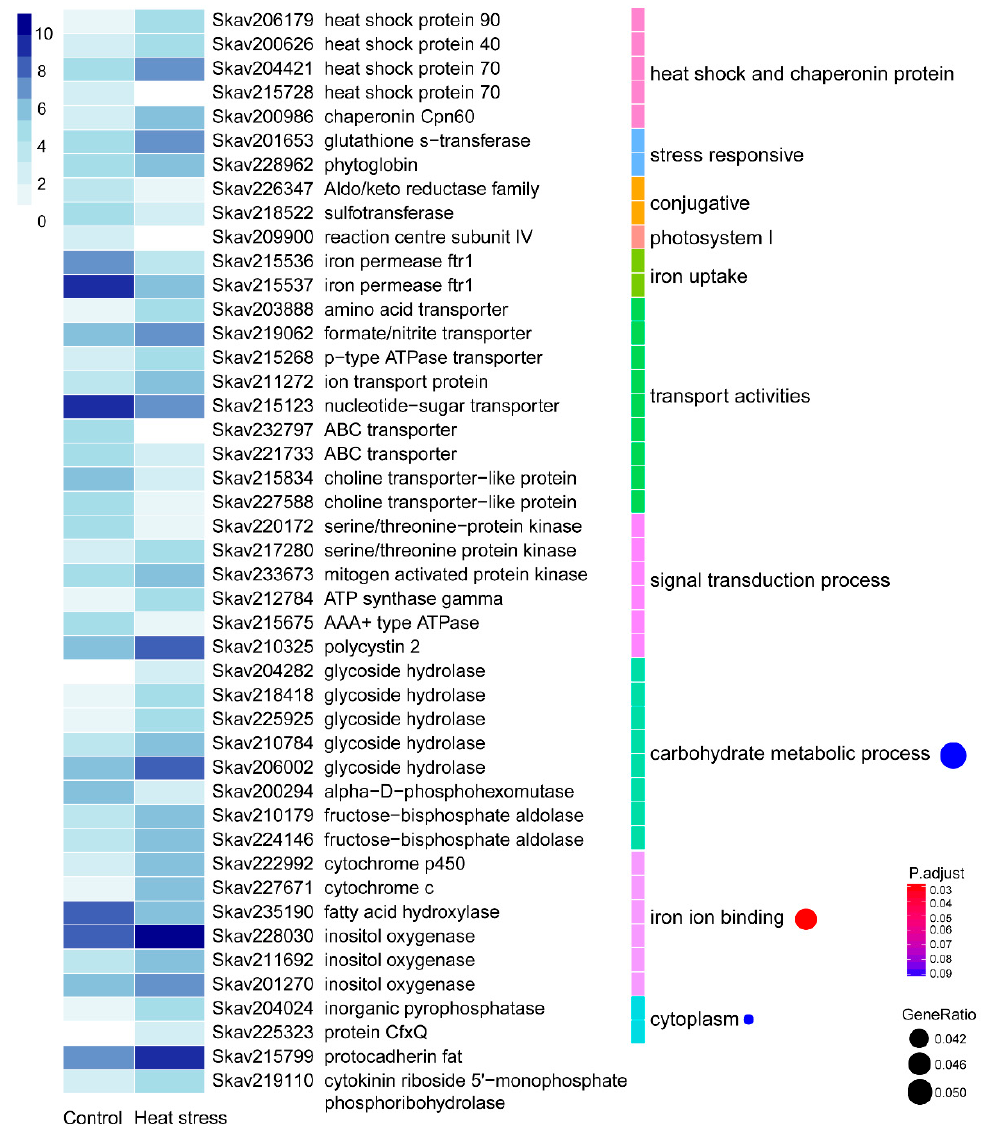
Figure 2. Differential gene expression in response to heat stress (30 °C). The heatmap color strength represents log2-transformed gene expression levels estimated as fragments per kilo-base of exon model per million mapped fragments (FPKM), from dark blue (highest), light blue, to white (lowest). Each color bar on the middle right marks a functional category. Each dot on the right marks a category based on GO enrichment ( p -value cutoff = 0.1). The dot size represents the enriched DEGs count. The color strength represents the p -value. Control: SymkaSL2 grown in L1 medium at 25 °C. HS: SymkaSL1 was grown in L1 medium at 30 °C.